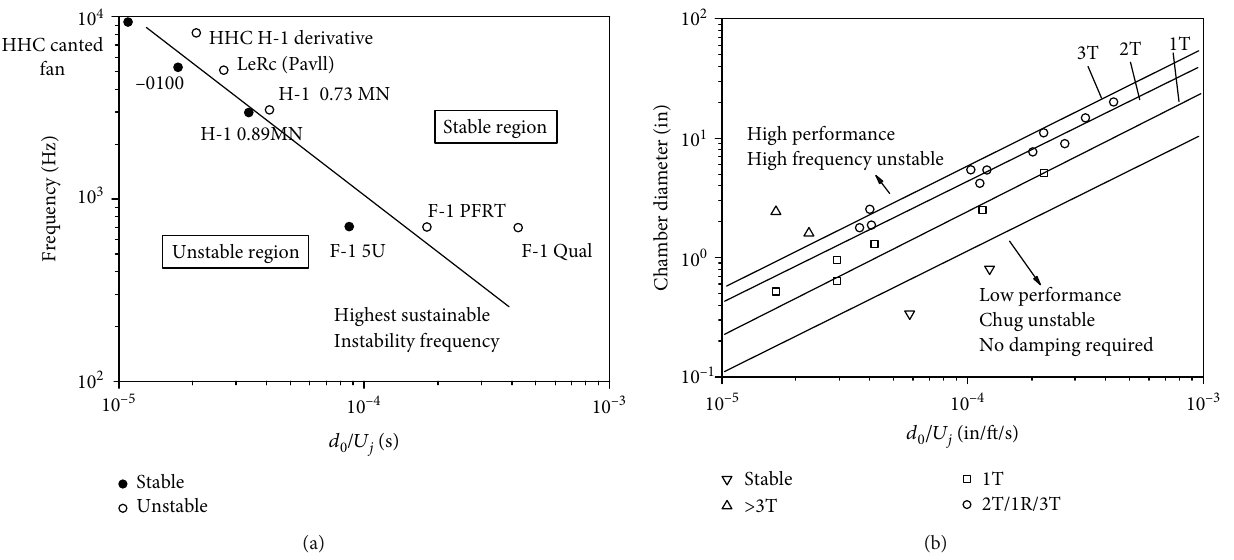
Figure 2: The Hewitt Stability Correlation [42]. (a) The eigenfrequency of the combustor. (b) Chamber diameter.